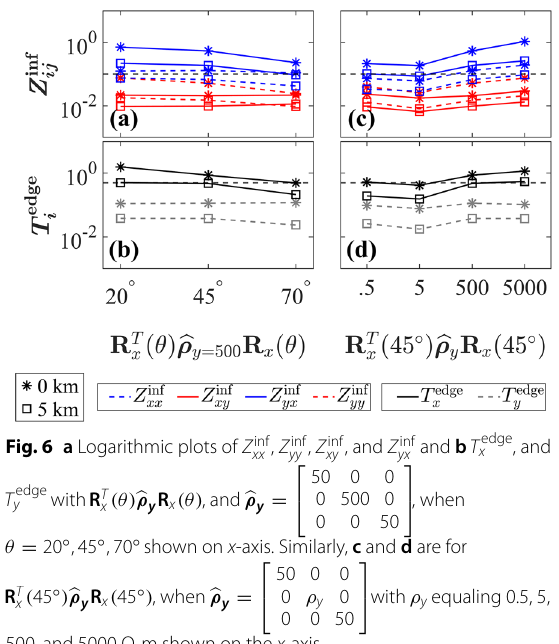
T ( 70 ◦ ) ρ R x ( 70 ◦ ) . In addition, perform- Fig. 5e and f for R y x (cid:31) T ( 45 ◦ ) ing R x (Fig. 5g and h) yields symmetrical images about the x-axis of Fig. 5a and b for the impedance tensor indices but not the tippers (due to a fixed edge station as reference).